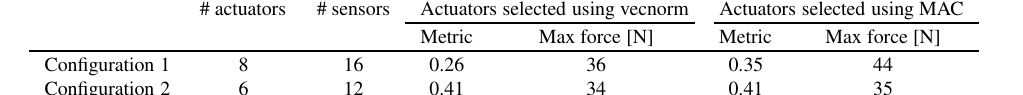
Table 1 Means of performance metrics for configurations 1 and 2 using optimal compensator